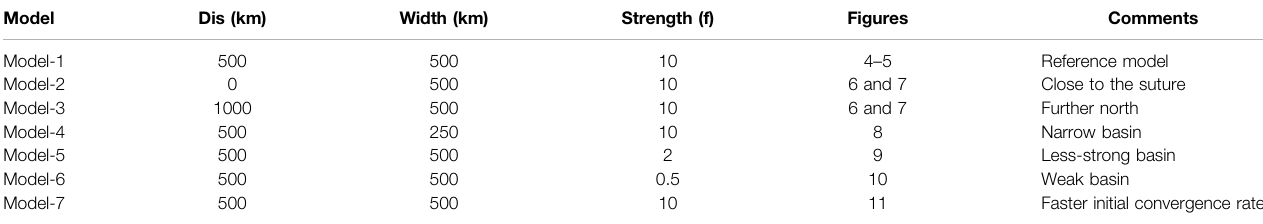
TABLE 2 | Parameters and results of experiments.